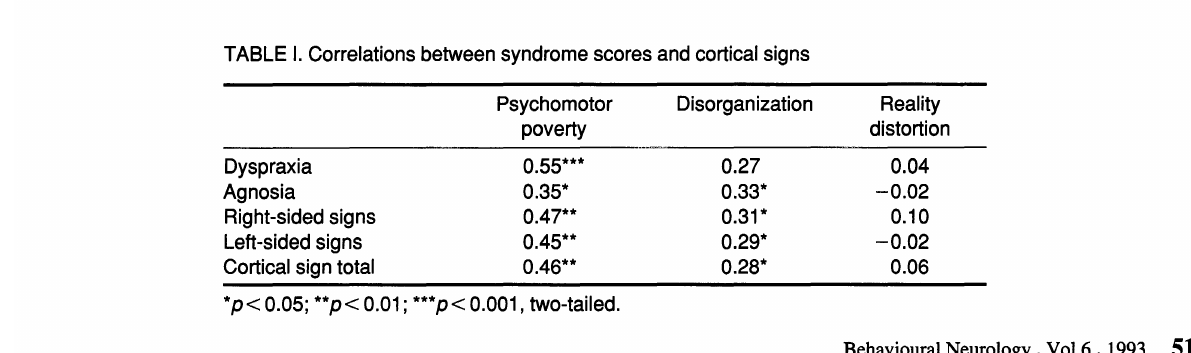
TABLE I. Correlations between syndrome scores and cortical